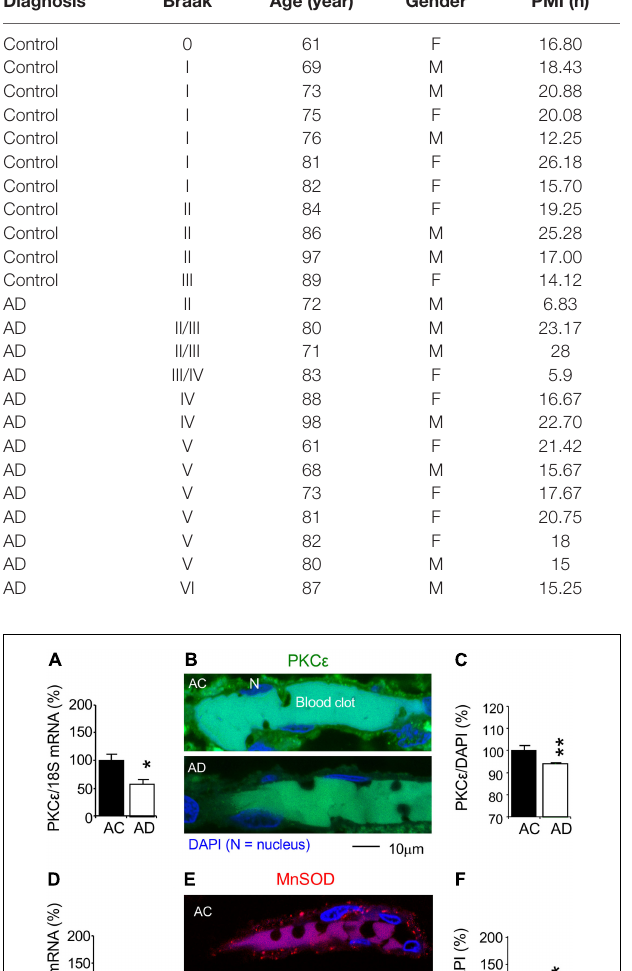
TABLE 1 | Demographic data of human brains.